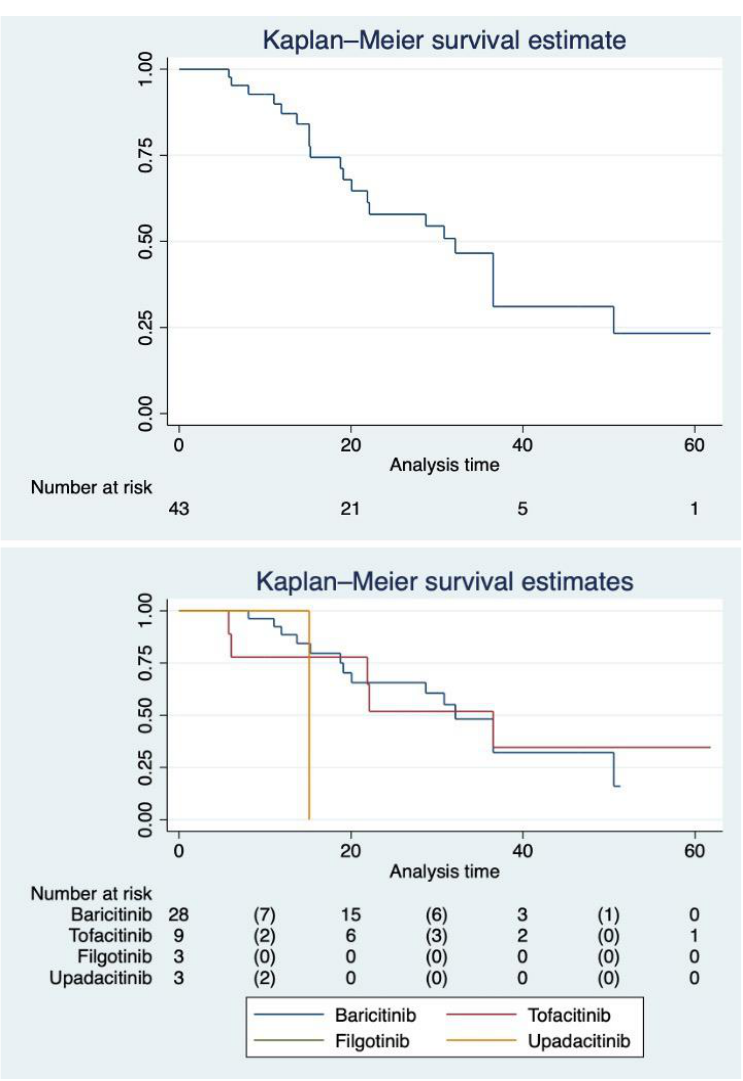
Figure 2. Survival function of patients with RA-ILD on JAKi. Upper panel: survival function in the whole cohort with the at-risk panel. Lower panel: survival function stratified by different JAKi with at-risk panel.